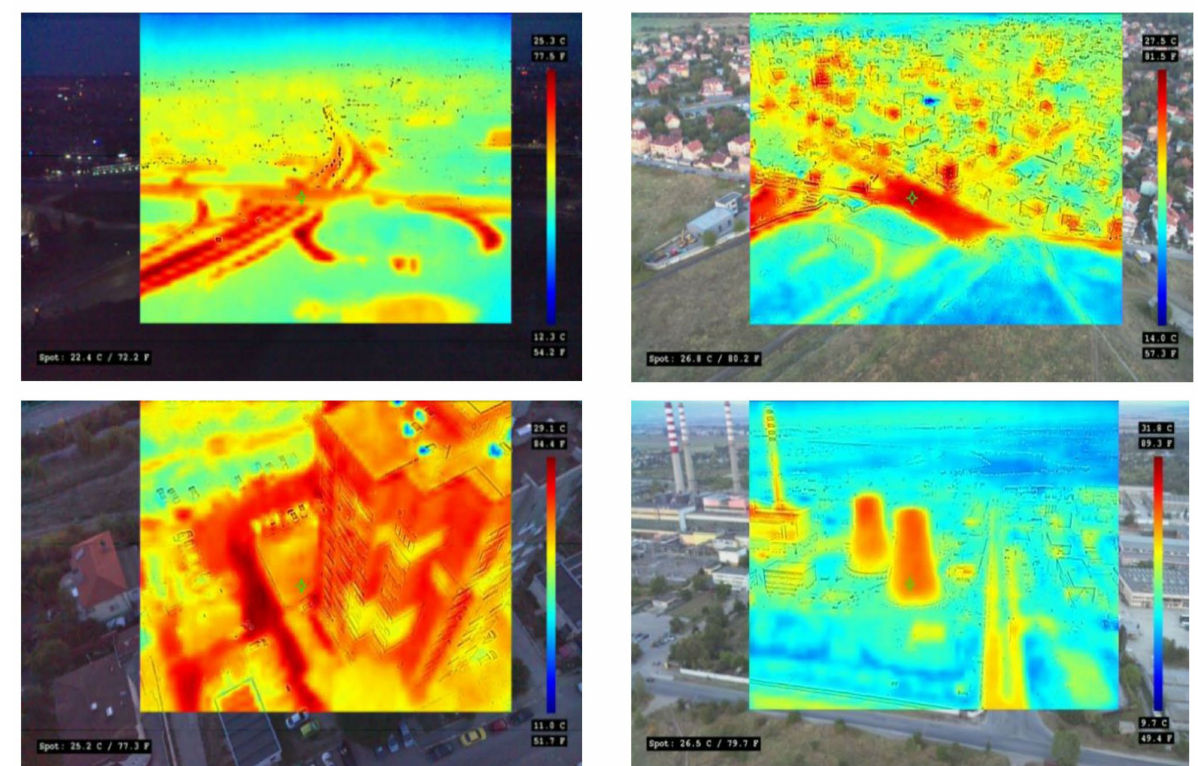
Figure 2. Examples of thermal images from the UAV